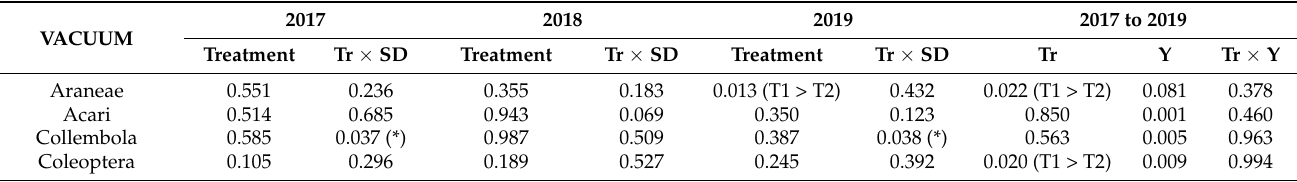
Table 1. Significance ( p ) of the Treatment and the interaction Treatment × Sampling Date (Tr × SD) for the most important parameters registered in the visual and vacuum sampling methods for 2017 to 2019. A repeated-measures ANOVA was used to analyze the data in each year and the three years pooled